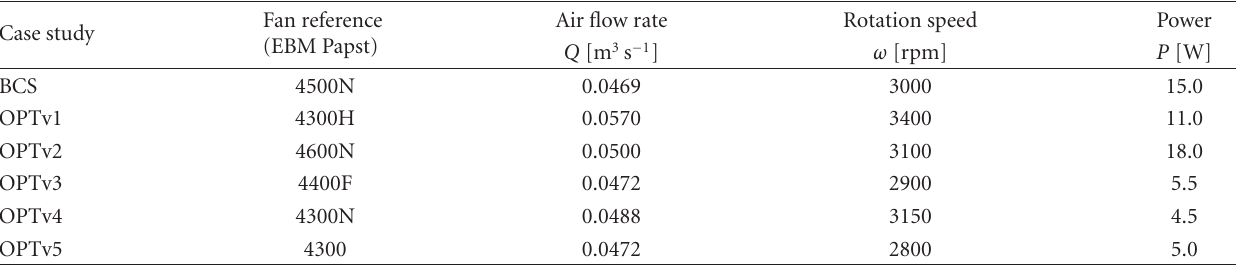
Table 1: Fans main technical characteristics.